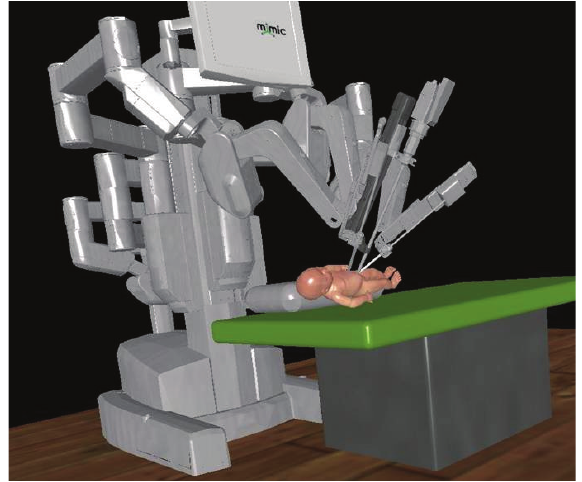
Figure 5: Patient-specific virtual reality robot docking simulation (Courtesy of MIMIC Technologies, Inc., Seattle, WA,